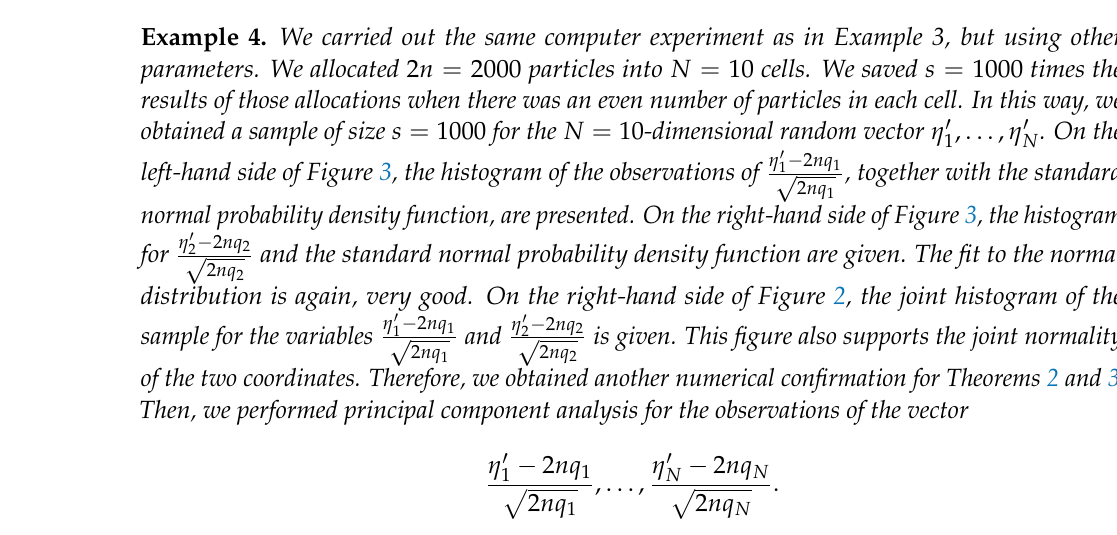
Figure 1. The histograms of the first and the second coordinates in Example 3. ( a ) First coordinate; ( b ) Second